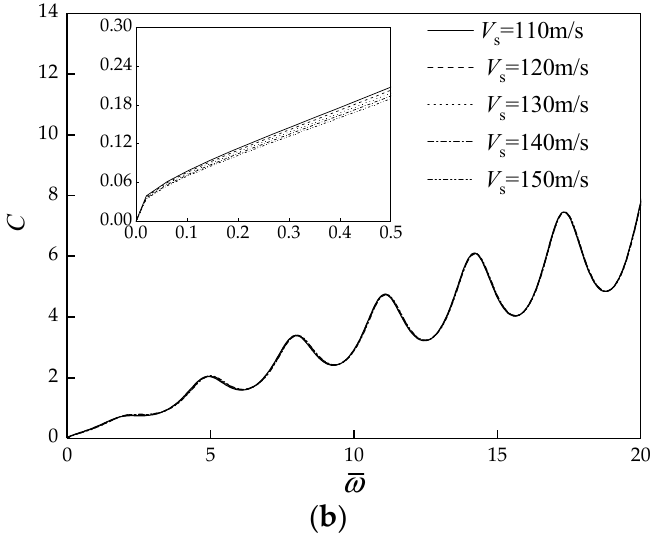
Figure 9. Effect of shear wave velocity of sediment on the vertical dynamic impedance of rock-socketed pile. ( a ) Dynamic stiffness curves; ( b ) Dynamic damping curves.